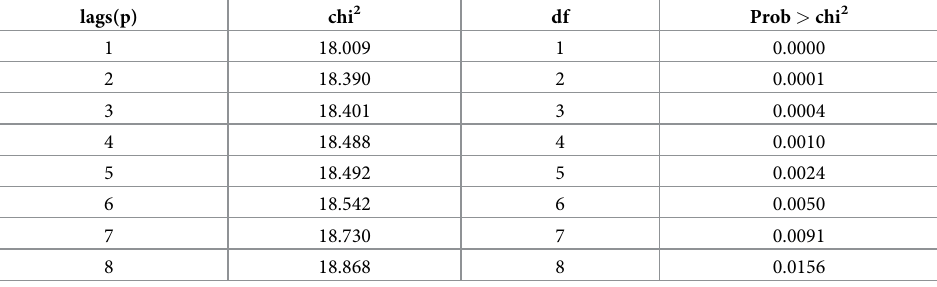
Table 5. ARCH LM